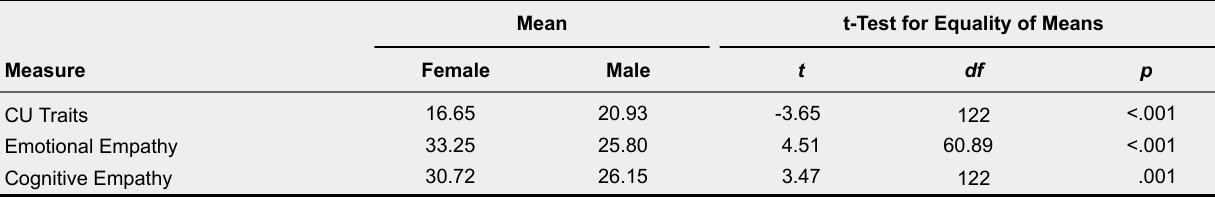
Correlations Between the Self-Report Measures of CU Traits and Empathy in Males and Females Emotional Empathy Cognitive Empathy Gender r p r p Female -.63 <.001 -.50 <.001 Male -.59 <.001 -.40 .005 Disassociation Between Emotional and Cognitive Empathy A significantly stronger negative association was observed between the CU trait and emotional empathy coefficient, than for the CU trait and cognitive empathy coefficient ( Z = 2.13, p = .03). Dysfunction in H